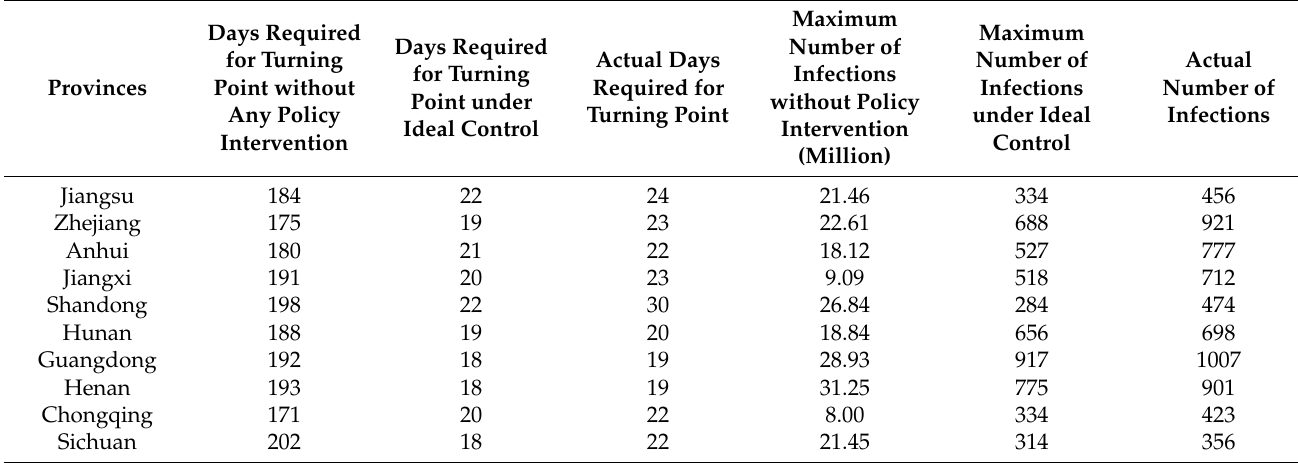
Table 2. The prediction of the SEIR model in various provinces of